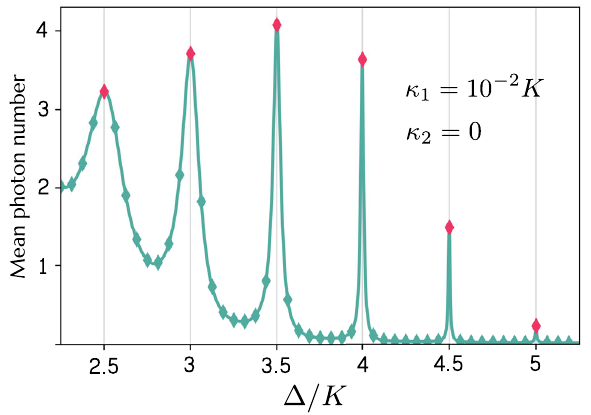
FIG. 6. Photon antiblockade. Average cavity- a steady-state photon number as a function of the drive detuning Δ with drive amplitudes fixed at Λ 1 ¼ Λ 2 ¼ K= 2 , Λ 3 ¼ 0 . Resonances here correspond to having tuned the parameter r 2 [cf. Eq. (40)] to be near a non-negative integer. Other parameters are κ 1 ¼ 0 . 01 K , 0 κ 2 ¼